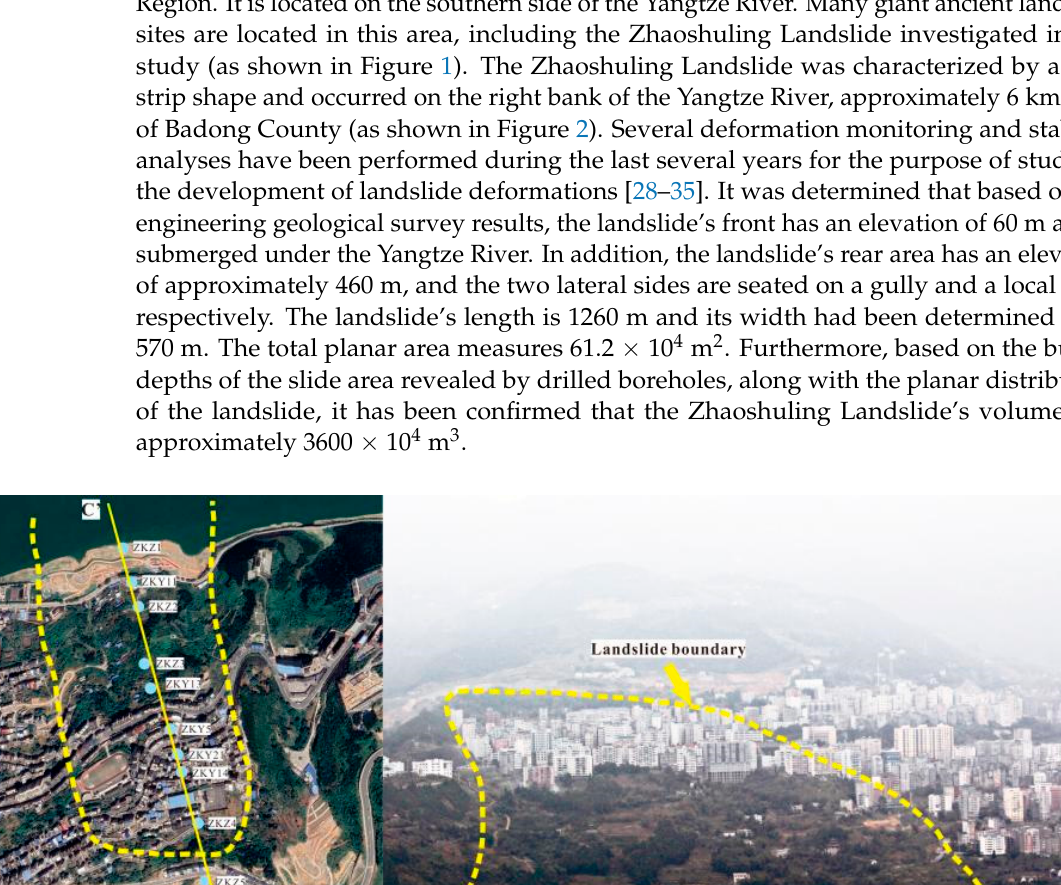
Figure 3. Engineering geological cross-section of the Zhaoshuling Landslide (C-C’). The structural features in the study area were found to be characterized by an E–W trending of multiple folds, as well as a series of reverse faults. The major feature among the fold structures was the Guandukou Syncline, in which the fold axis was observed to strike in a nearly E–W direction and axial trace extended along the southern bank of the Yangtze River. The syncline had manifested as an iso-thick symmetrical fold in the section. In addition, many asymmetrical secondary interlayer folds existed on the two flanks of the syncline, which were found to be mainly developed in the soft formations of the T 2 b 3 strata. In regard to the E–W trending reversed faults, the bedding faults or bedding shear zones were observed to be developed following a pattern of E–W folds due to extensive deformational forces. Additionally, along with the above-mentioned fault features, there